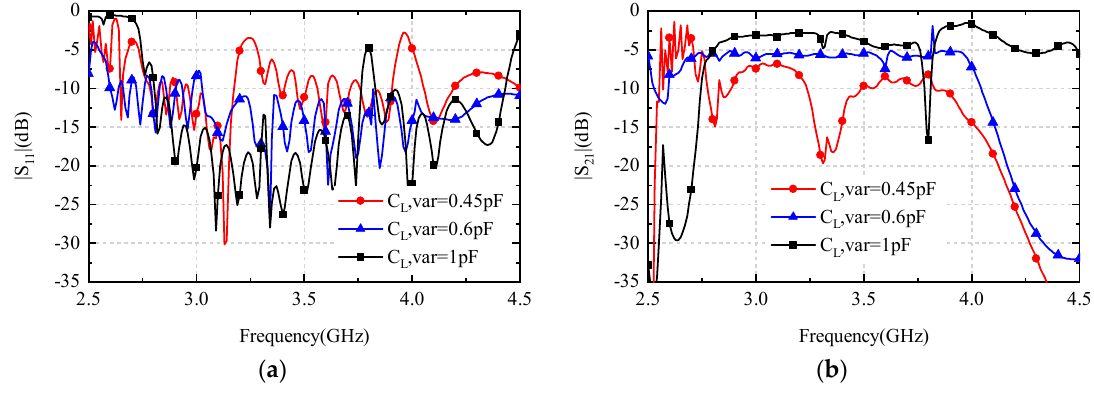
| and | S | of a 20-cell LWA with di ff erent capacitance values. ( a ) | S 11 21